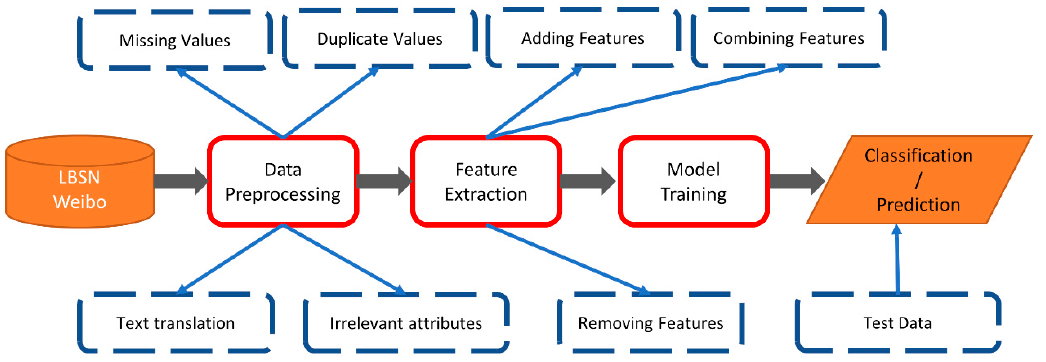
Figure 1. Pictorial representation of classification .